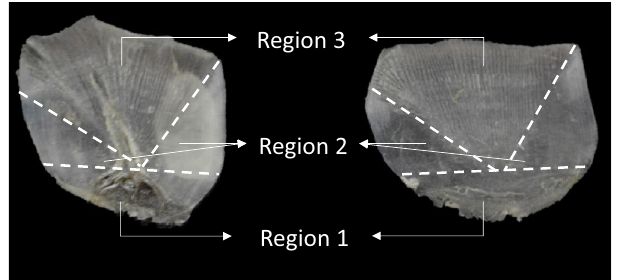
Figure 6. Scales from Argyrosomus thorpei divided into specific regions for DNA extraction (Photo by ©L. Shuttleworth, edited in MS PowerPoint Build